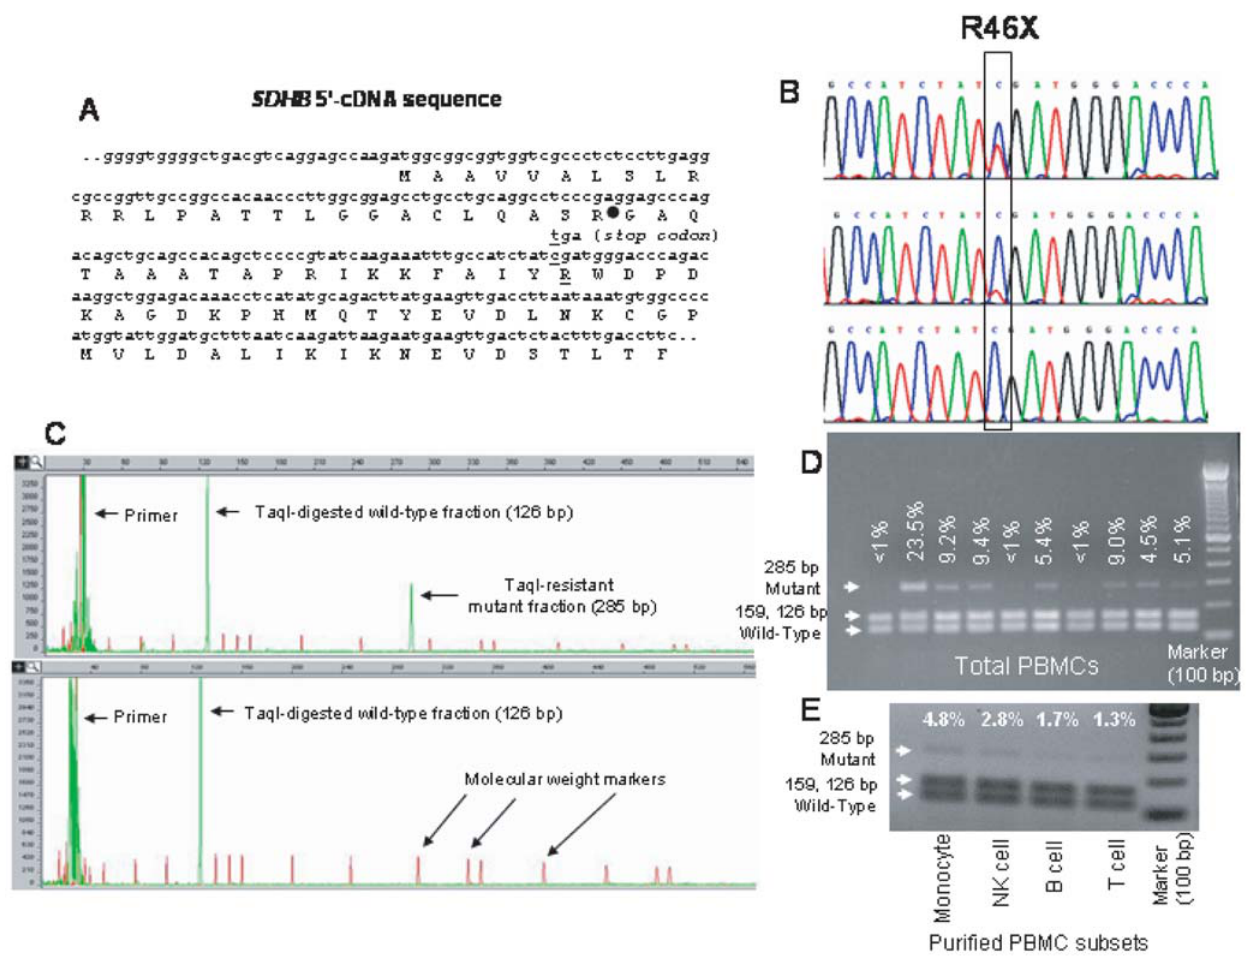
Figure 1. Analysis of SDHB R46X mRNA mutation. A. The SDHB gene has 843 bp coding nucleotides spread to 8 exons within , 35 kb at chromosome band 1p36.13. The 5 9 - portion of the gene shows the position of the R46X mutation and the mitochondrial signal peptide cleavage site (filled circle). B. Sequence chromatograms of RT-PCR products show samples that have high (top), low (middle), or undetectable (bottom) amounts of mutant R46X sequences. C. Quantification of the mutant fraction involved Taq I RE digestion of fluorescently-labeled RT-PCR products and capillary gel electrophoresis. The red peaks denote the molecular weight marker. D. The agarose gel electrophoresis shows variable fractions of mutant RT- PCR products from normal PBMCs detected by Taq I RE digestion, which releases two bands 159 and 126 bp in size from the wild-type sequence (also see Fig. S1A). E. Fractions of Taq I RE resistant transcripts in the purified PBMC cell types are shown in an agarose gel. The negative image is presented to enhance the visibility of mutant